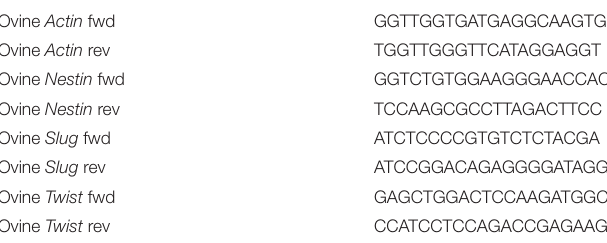
TABLE 1 | Primer sequences for